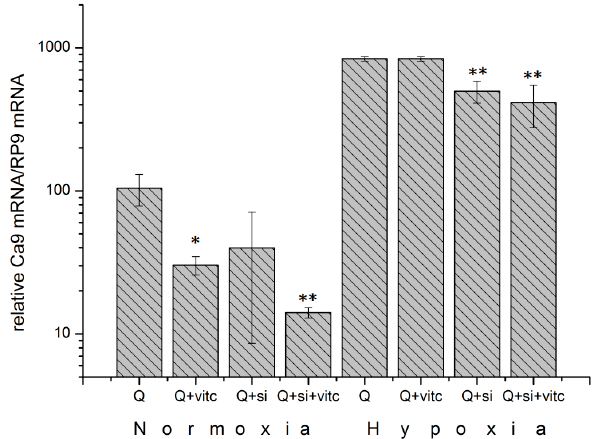
Figure 7. Reduction of relative CA9 mRNA expression under normoxia and hypoxia (<0.1% oxygen) 24 h after the application of 5 mM glutamine (Q) and 100 μ M ascorbic acid (vitc) or HIF1 α siRNA